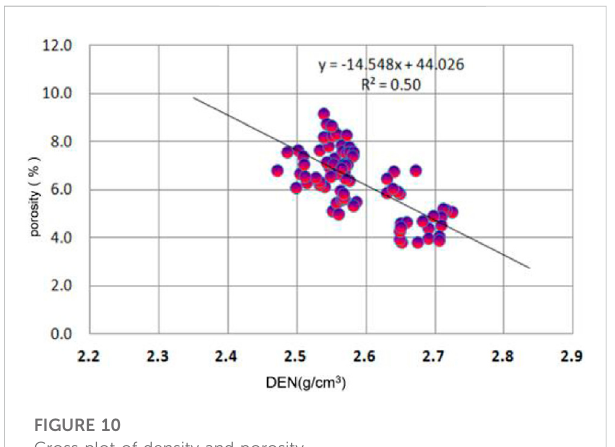
FIGURE 10 Cross plot of density and porosity.